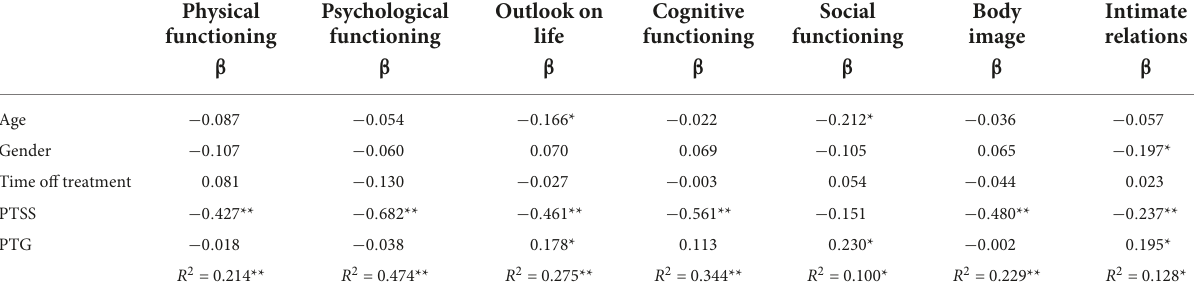
TABLE 4 Regression analyses controlling for age, gender a time off-treatment in the adolescent group ( N =